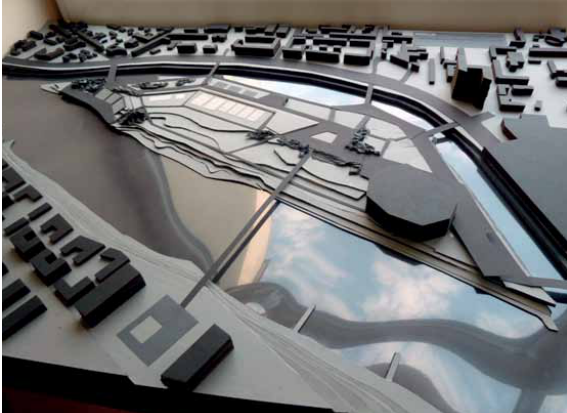
project1 fig. 1. anstract painting helps to develop creativity and ability to formulate ideas while using different artistic